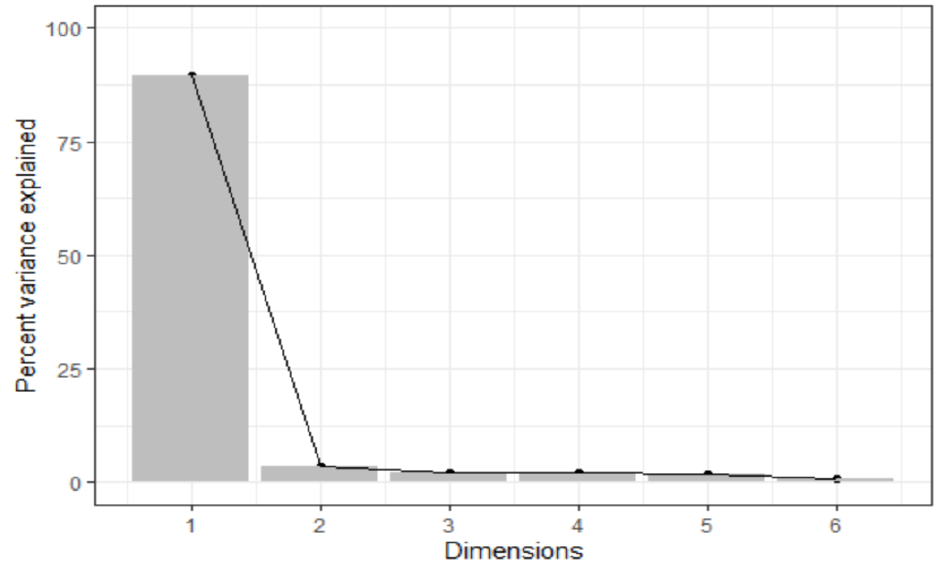
Figure 1. Scree plot showing the variance contributed by the principal components for the cognitive function tests.